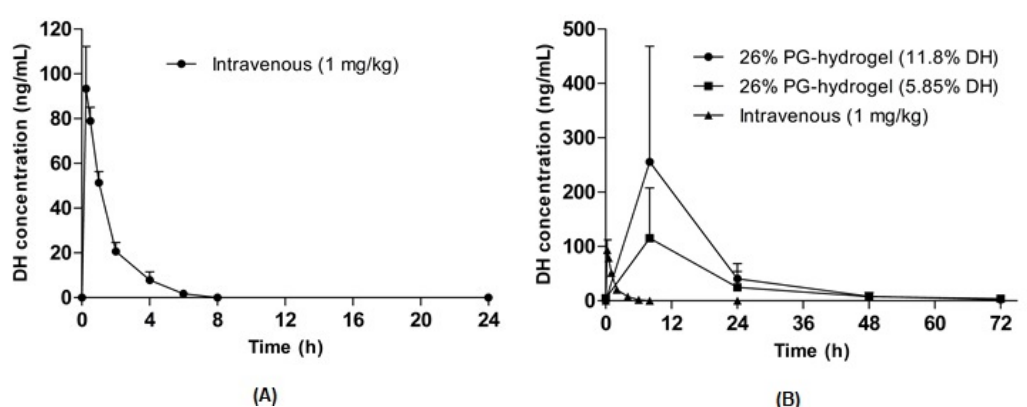
Figure 7. Pharmacokinetic profiles of donepezil hydrochloride (DH) in hairless rats. Intravenous injection of DH (1 mg/kg) ( A ) and the plasma concentration-time curve for 72 h after the application of DH hydrogel-patches ( B ). Data are expressed as the mean ± standard deviation ( n = 5).